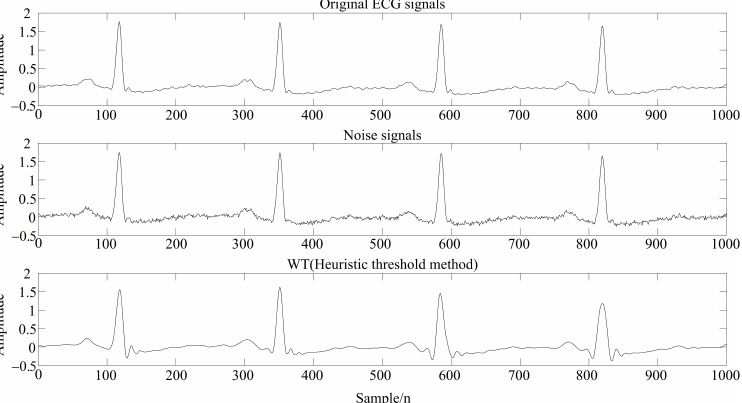
Figure 3. Filtering effect of wavelet threshold denoising (heuristic threshold) of ECG signals.